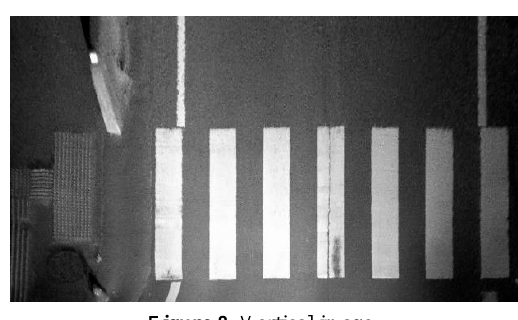
Figure 8 . Vertical